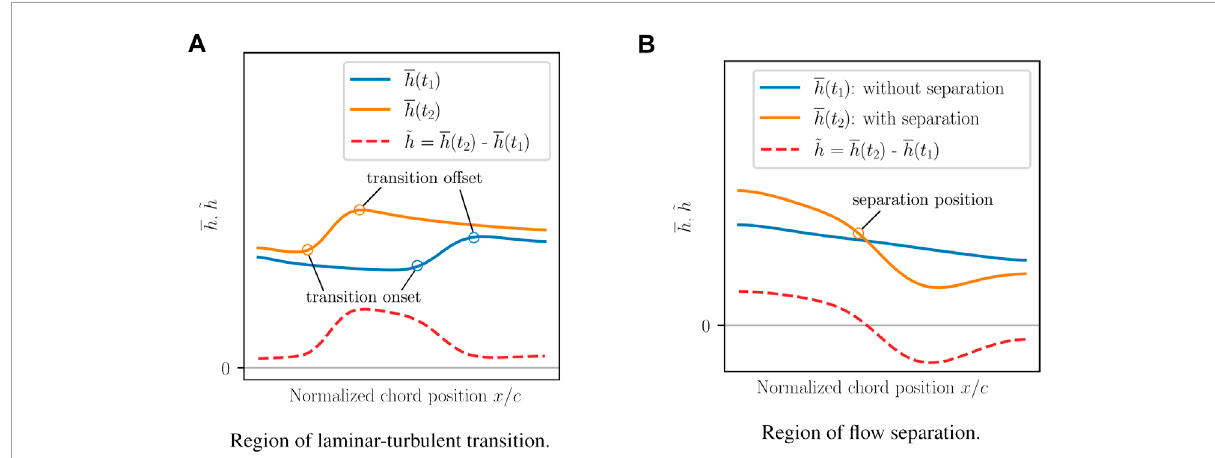
FIGURE 1 Idealised course of the mean value h and the non-stationary part ̃ h of the heat transfer coefficient over the normalised chord position x / c for the regions of transition (A) and flow separation (B) at the time steps t 1 and t 2 during a gust. The first step t 1 is immediately before the onset of a gust, while t 2 represents a time during a gust with increased effective inflow velocity and angle of attack, thus: t 1 < t 2 , α ( t 1 ) , < α ( t 2 ) and U eff ( t 1 ) < U eff ( t 2 )